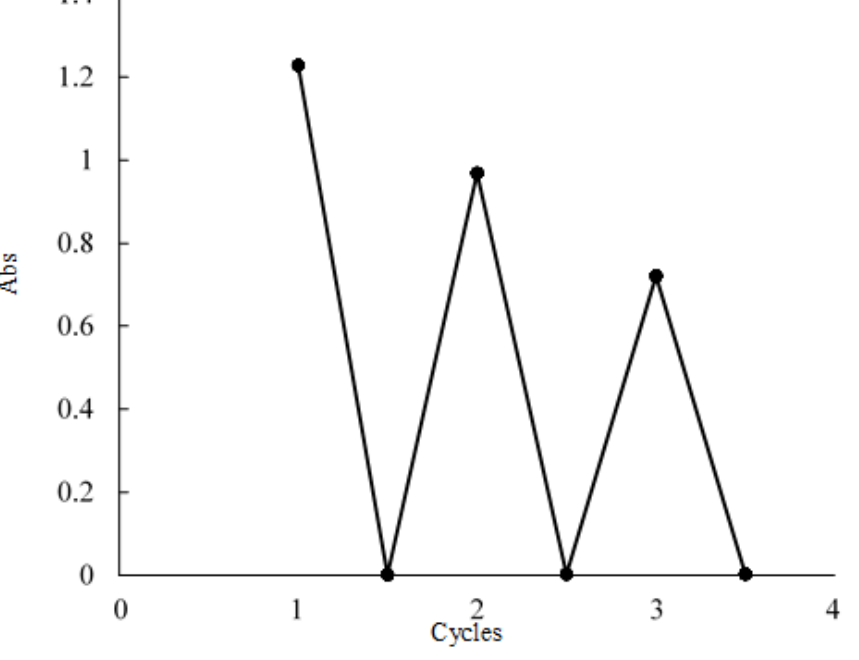
Figure 5. Coloration–decoloration cycles of TBA-1 in DMSO/methanol (83:17 vol%) solution, monitored by absorbance at 655 nm.